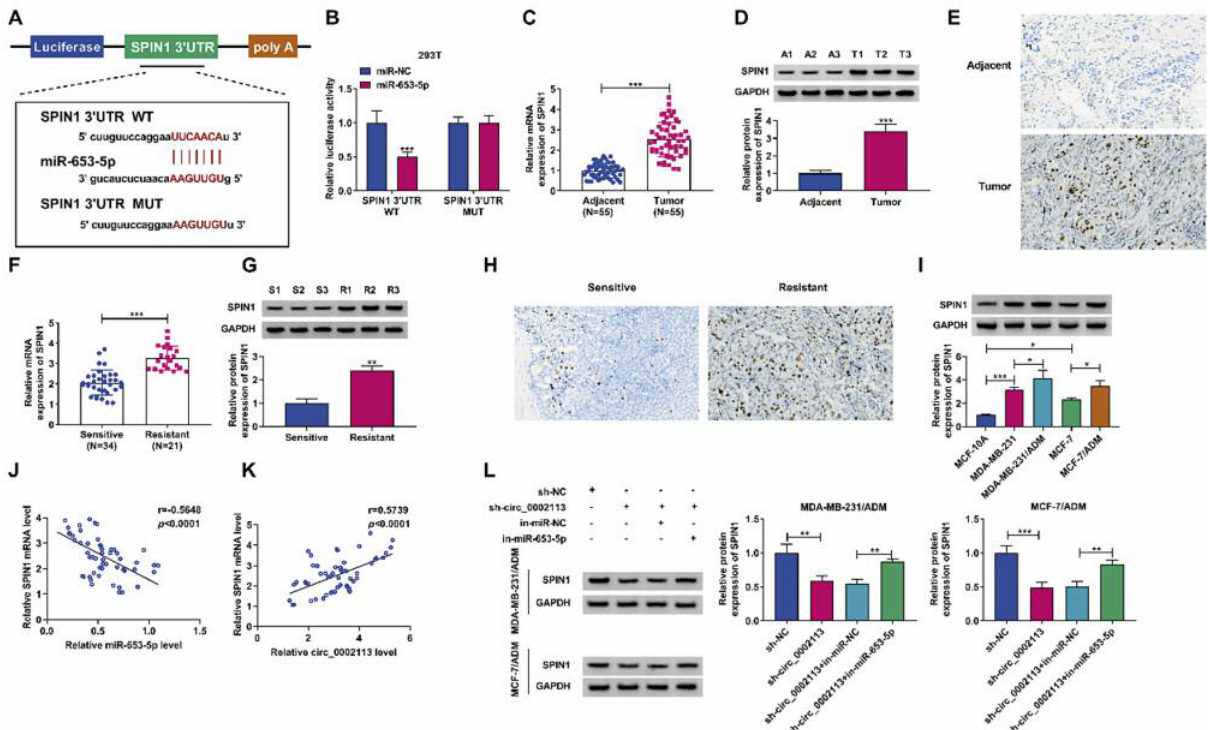
Fig. 6. Circ_0002113 promoted SPIN1 level by binding to miR-653-5p. (A-B) SPIN1 3’UTR and miR-653-5p binding was predicted by starBase (A) and a ffi rmed by dual-luciferase reporter assay (B). (C-H) SPIN1 mRNA and protein levels were assayed by RT-qPCR and western blot/IHC in normal/BC samples (C-E) and ADM-sensitive/resistant samples (F-H). (I) Western blot was used for protein detection of SPIN1 in ADM-resistant BC cells. (J-K) Pearson’s correlation coe ffi cient was performed to analyze the relation between SPIN1 and miR-653-5p (J) or circ_0002113 (K). (L) SPIN1 protein level was measured via western blot following sh-NC, sh-circ_0002113, sh-circ_0002113+in-miR-NC or sh-circ_0002113+in-miR-653-5p transfection. * p < 0.05, ** p < 0.01, *** p <